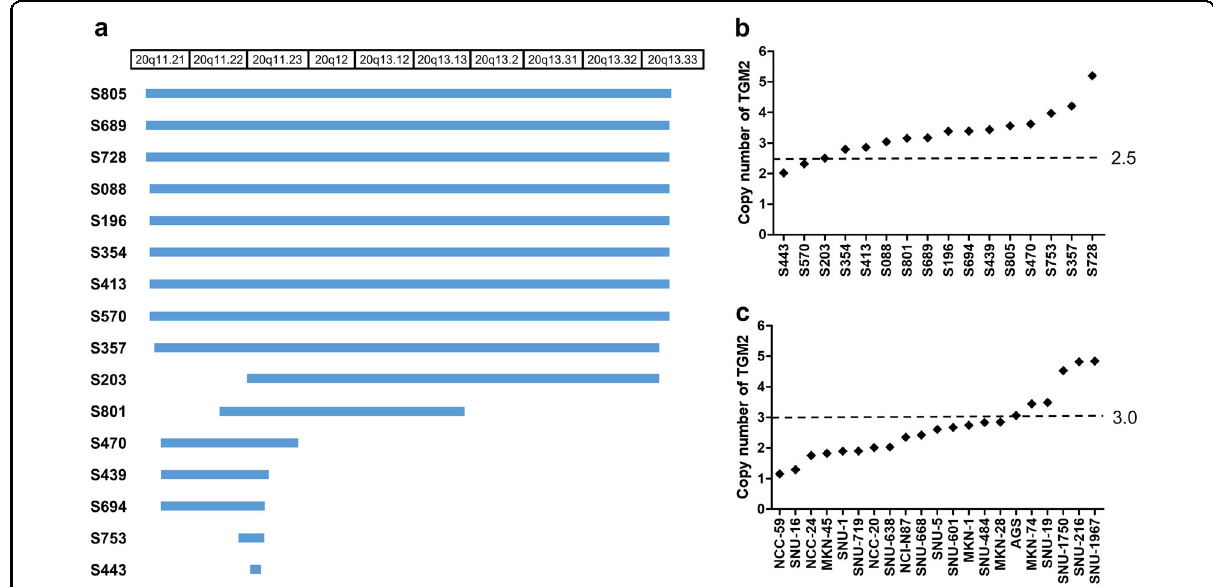
Fig. 1 Copy number ampli fi cation of TGM2 in gastric cancer (GC). a The chromosomal locations of TGM2-containing amplicons in 16 TGM2- ampli fi ed GC patients estimated by array comparative genomic hybridization (aCGH). b , c Estimated copy numbers of TGM2 in 16 TGM2-ampli fi ed GC patients ( b ) and 21 GC cell lines ( c ) evaluated by droplet digital PCR (ddPCR). Error bars indicate the Poisson 95% con fi dence interval for each determination. The dashed line indicates the ddPCR threshold cut-off of 2.5 or 3.0 copies for calling a sample TGM2 ampli fi ed in the GC patients ( b ) and GC cell lines ( c ),